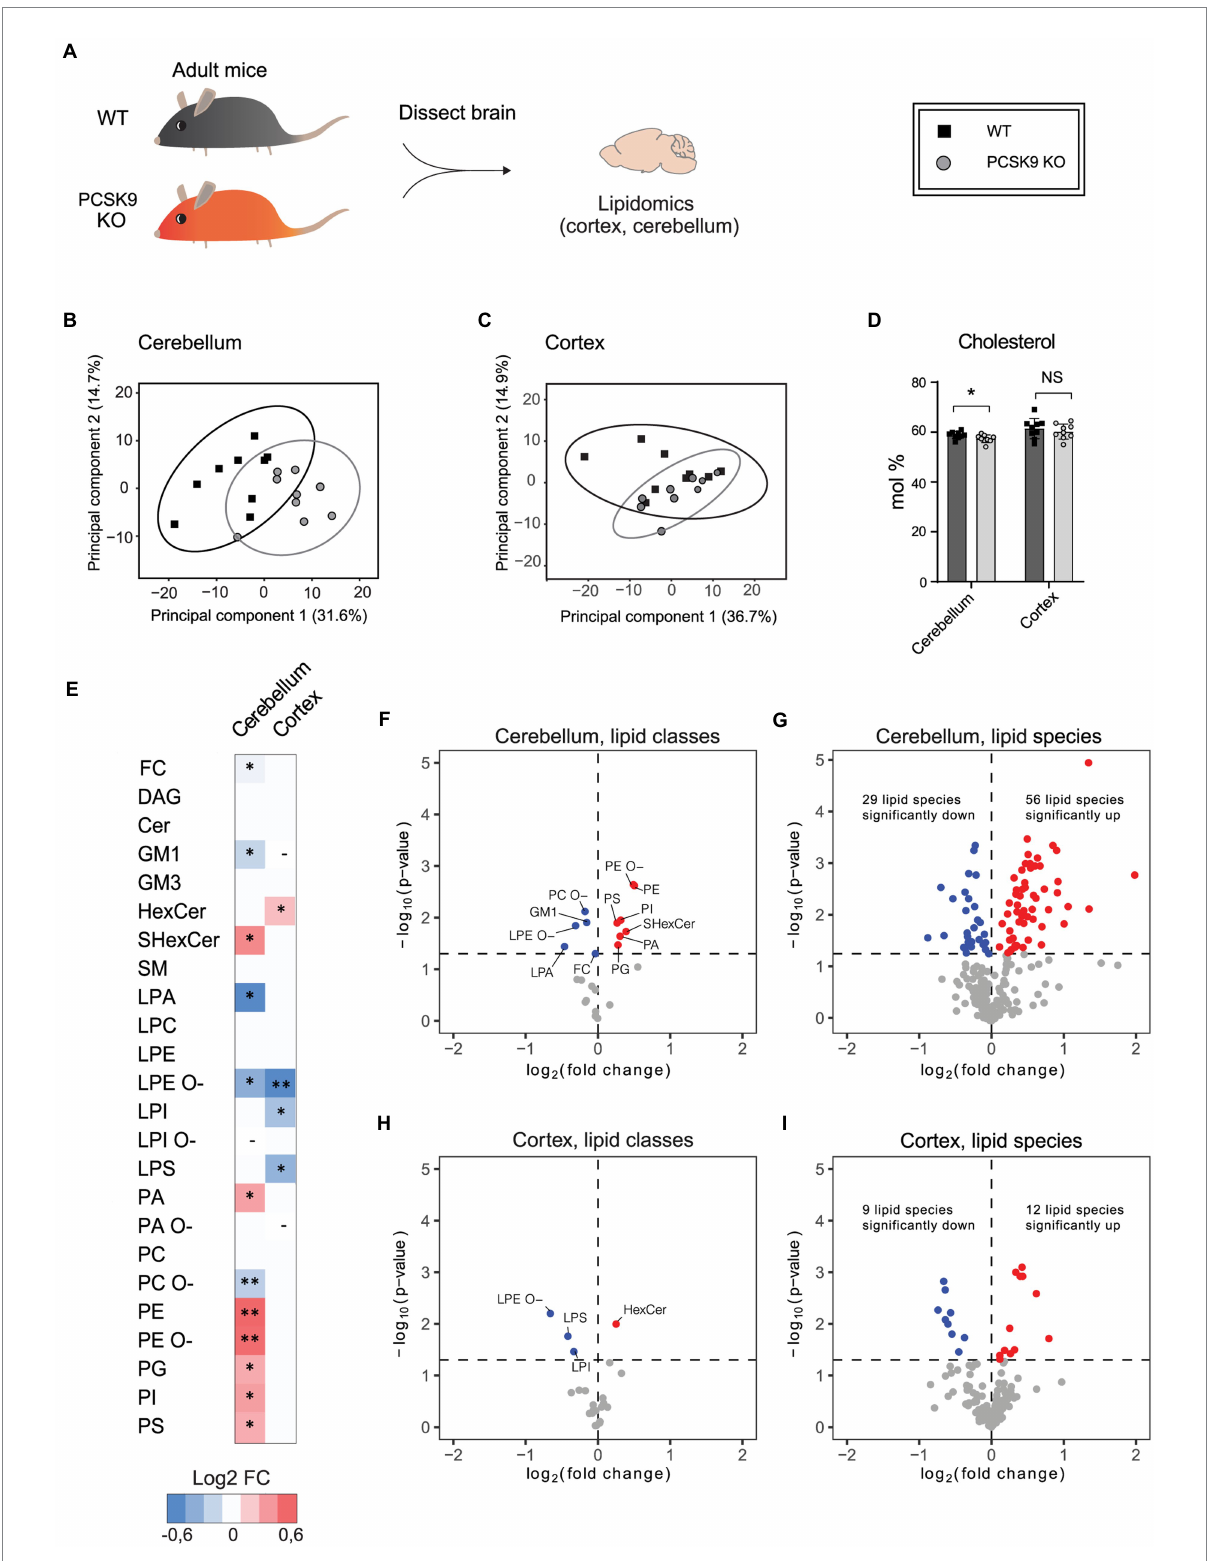
FIGURE 3 The effect of PCSK9 deficiency on lipids in cerebellum and cortex. Lipid profiles of mouse cerebellum and cortex were analyzed using a quantitative mass-spectrometry based shotgun lipidomics method. (A) Schematic representation of the experiment. (B,C) Principal component analysis showing different clustering of WT and KO cerebellar (B) and cortical (C) lipidomes. (D) Cholesterol (FC) content in mol% in WT and